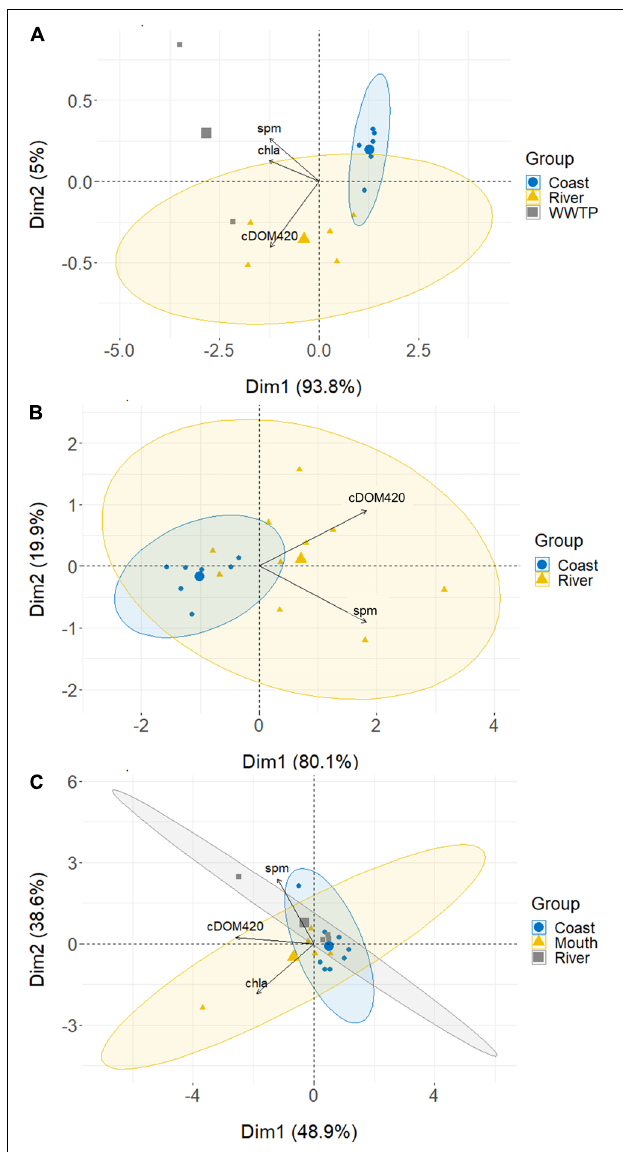
FIGURE 3 | Biplots of the Trave river (A) , the Elbe estuary (B) , and the Po delta (C) showing the scores of individual samples grouped by different symbols and colors. Loadings of the predictor variables chlorophyll-a (chla), suspended particulate matter (spm), and colored dissolved organic matter (cDOM420) on the first two principal components (Dim1 and Dim2) are represented as vectors. Larger symbols depict the center of the confidence ellipse (95% confidence level) drawn around the